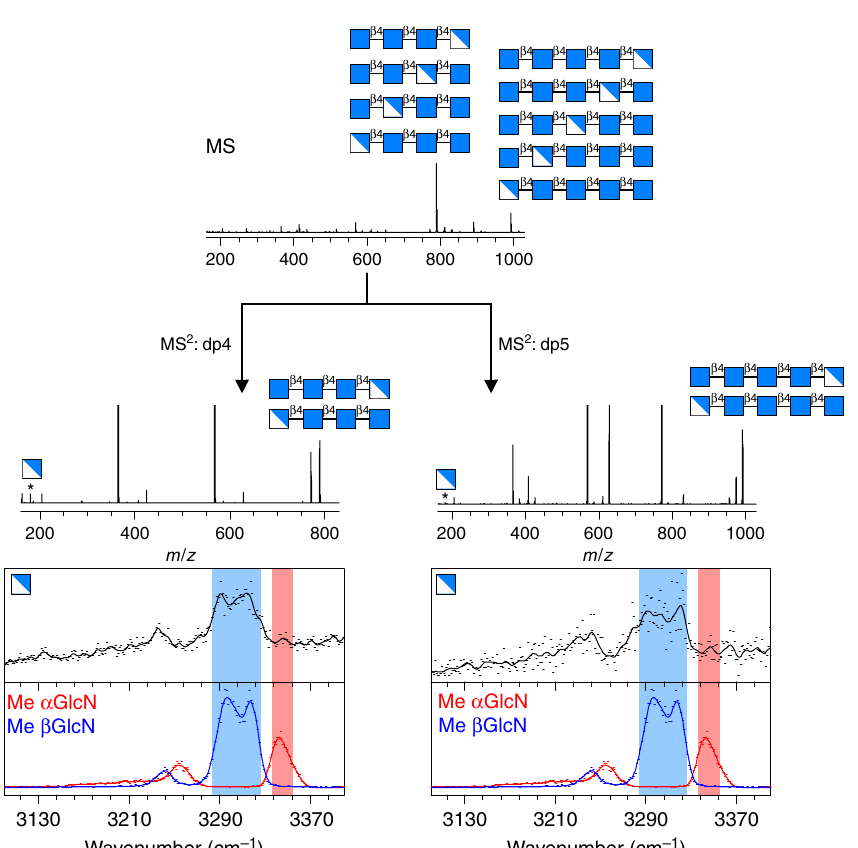
Fig. 3 Illustration of the carbohydrate-sequencing procedure in the case of a crude mixture of chito-oligosaccharides: the degree of polymerisation and the fraction of acetylation are resolved by MS; the set of candidate sequences is reduced by MS/MS analysis; the sequence is fully resolved by spectroscopic analysis of the GlcN fragment. Symbols from ref.